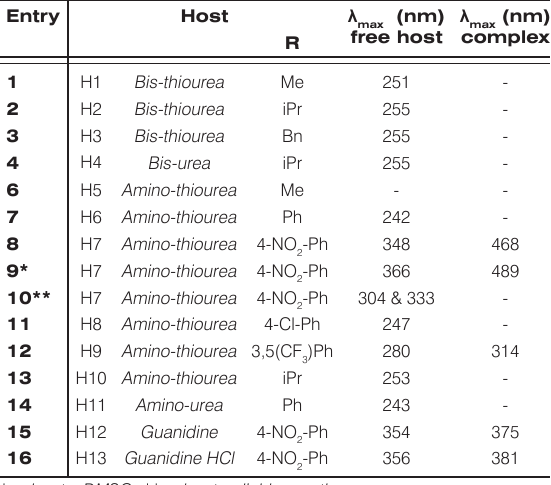
Table 2. Complexation study with TBAA in acetonitrile at H : G ratio of 1:24. Entry